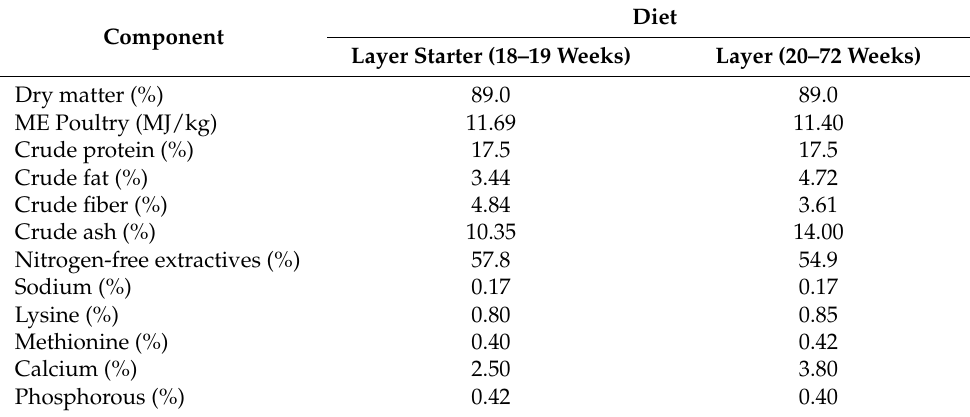
Table 1. Composition of the diets used in the examined egg-laying